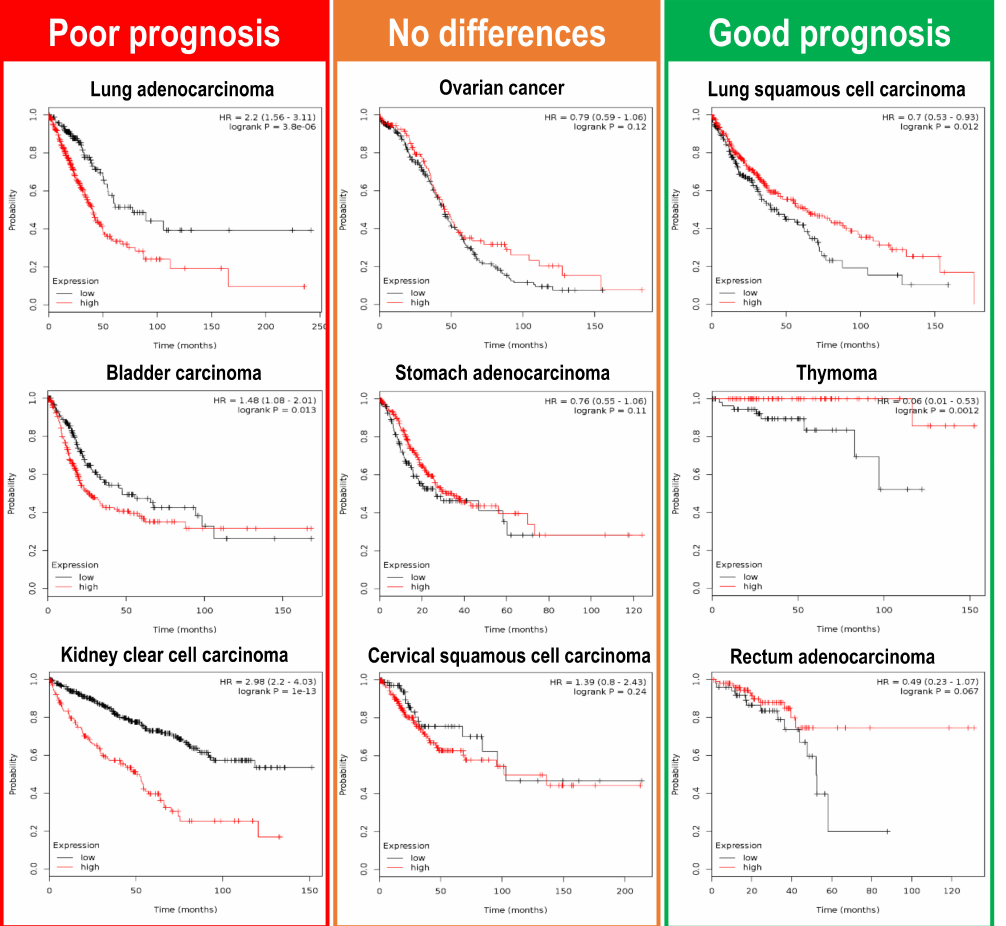
Figure 4. Clinical consequences of Plk1 upregulation in a pan-cancer RNAseq analysis. Overall survival (OS) analysis, in a large collection of different cancer types, retrieved from the Kaplan Meier plotter initiative (www.kmplot.com). mRNA sequence data obtained from nine different tumor types were plotted according to Plk1 expression levels (red line—high Plk1; black line—low Plk1). Lung, bladder, and kidney clear cell carcinomas have a poor OS when Plk1 levels are high. On the other hand, lung squamous cell carcinomas, thymoma, and rectum adenocarcinomas have a favorable OS outcome when Plk1 levels are elevated. Interestingly, there are also a variety of tumors where Plk1 expression have no influence in the OS for the patients (ovarian, stomach and cervical squamous